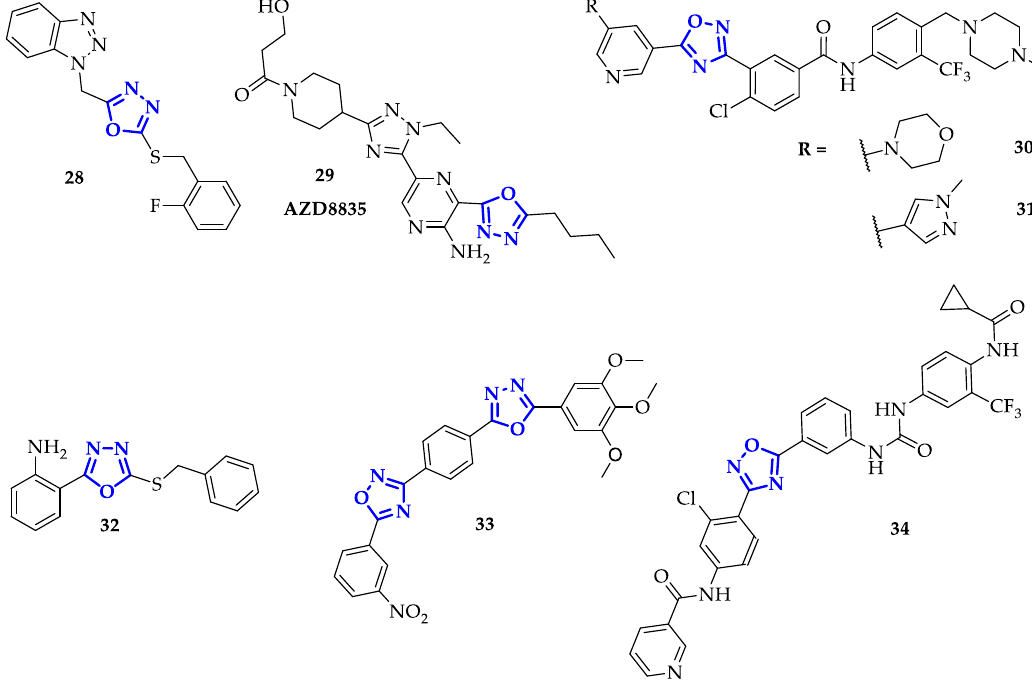
Figure 6. Oxadiazoles ligands that exploited kinases inhibition to reach an anticancer activity.